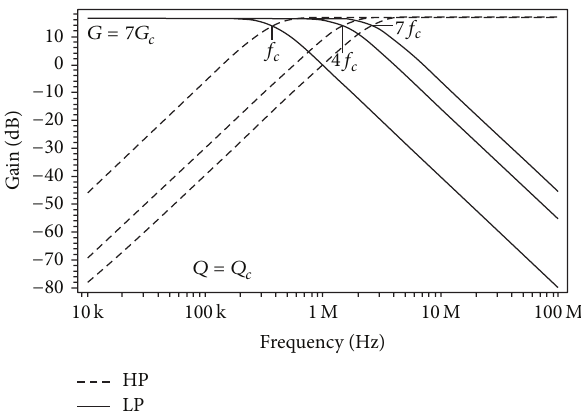
Figure 7: Pole frequency programming of HP and